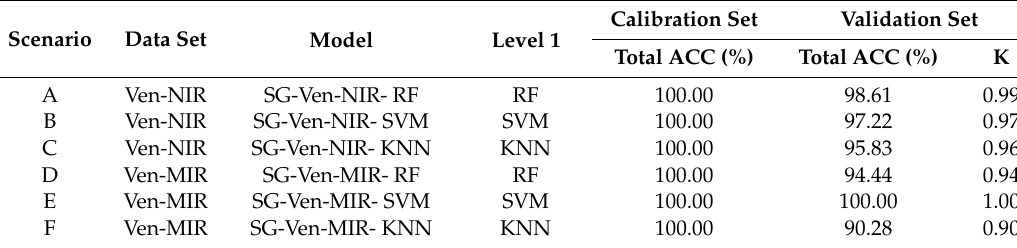
Table 9. The major parameters (accuracy and kappa) of the stacking models.